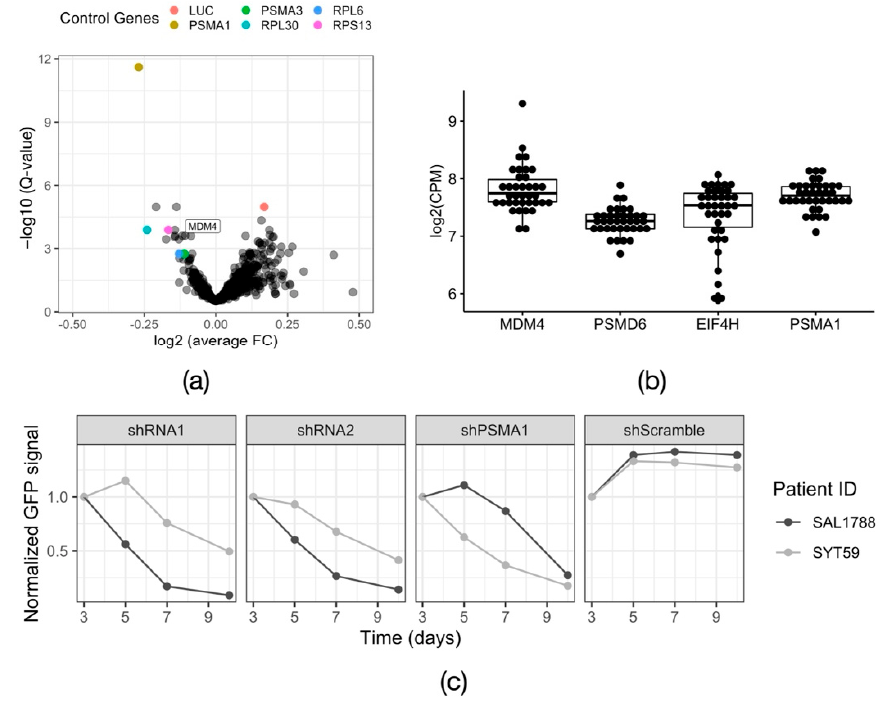
Figure 3. Validation of the screen hit MDM4. ( a ) Volcano plot visualizing the results of the combined RNAi screens in 9 primary patient samples. FC—fold change; LUC—luciferase. The p -values were calculated with the Wilcoxon rank-sum test and corrected for multiple testing using Storey’s method to obtain the Q-value. ( b ) Expression data for the candidate gene MDM4 and the housekeeping genes PSMD6, EIF4H, PSMA1 obtained from RNA-Seq of 37 DNMT3A R882X AML samples, including 18 samples in which the functional screens were performed. CPM—counts per million. ( c ) Growth dynamic of two primary DNMT3A R882X AML primary samples (SAL1788 and SYT59) expressing an shRNA against MDM4 (shRNA1 and shRNA2). The positive control PSMA1 (shPSMA1) and the non-targeting control (shScramble) are indicated. n = 1.